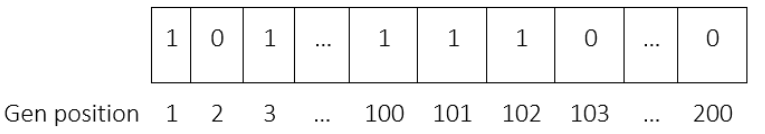
Figure 5. A random